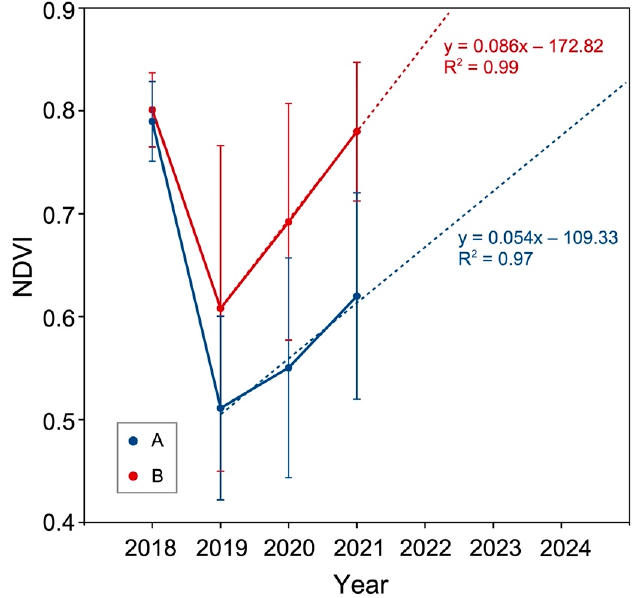
Figure 3. Average value (dot) ± standard deviation (bar) of NDVI of the two study areas (A, Val Malga; B, Vione) from July 2018 (before Vaia storm) to July 2021. The broken lines indicate the trends of the NDVI after the Vaia storm.